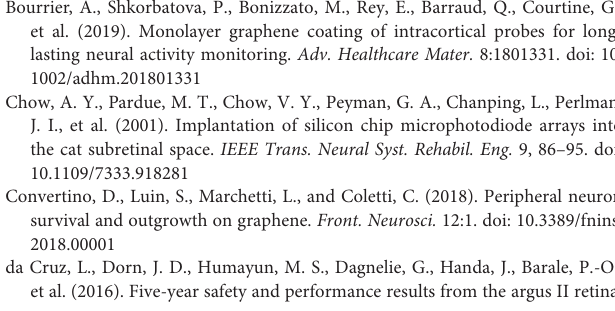
Supplementary Figure 1 | Typical imaging of eye fundus and OCT scan of non-implanted P23H rat at 9 and 12 months of age. The white line on the eye fundus indicates the location where the OCT scans were taken. The OCT scans shows the retina (white arrow), the choroid (yellow) and the sclera (blue). Dotted white box is a zoom of each OCT scan showing in detail the retina. All scale bars are 200 µ